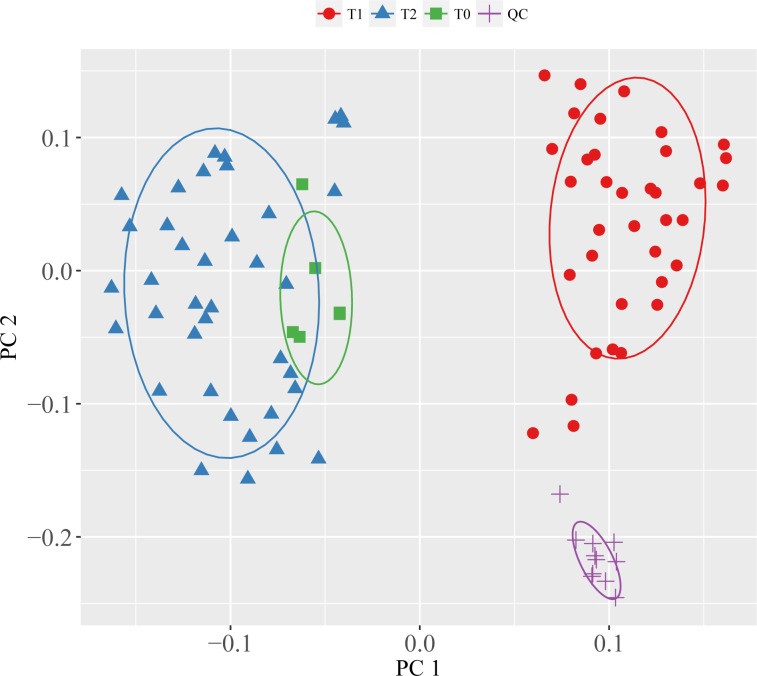
Principal component analysis scores plot showing the similarities and differences between the metabolic profiles of the grafts in donor (T0), cold (T1) and post-reperfusion phases (T2).The variance explained by PC1 = 39.82% and PC2 = 29.58. The close grouping of the donor and post-reperfusion biopsies along with their clear separation from the cold-phase biopsies (along PC1) is further supportive of the rapid resumption of the biochemical functions in the reperfused grafts and shows the direction of metabolic changes through the patient journey and the OLT procedure—from ‘healthy’ donor grafts through cold-phase to almost fully functional grafts post reperfusion.